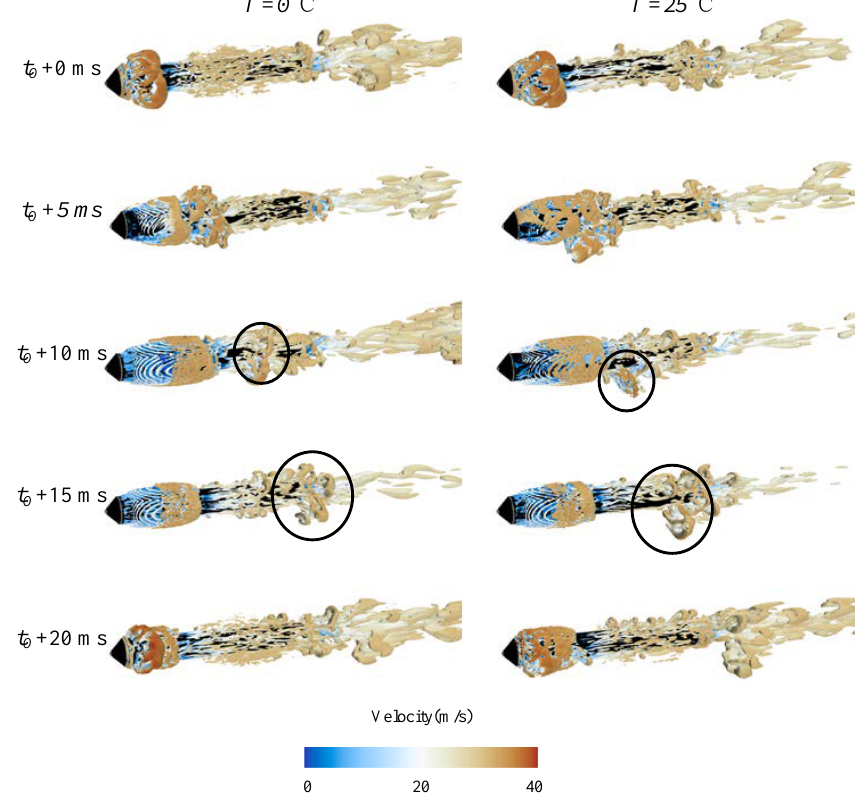
Figure 12. Comparison of the vortex structure of natural cavitation at 0 °C and 25 °C (isosurface of Ω = 0.52 colored according to velocity magnitude).